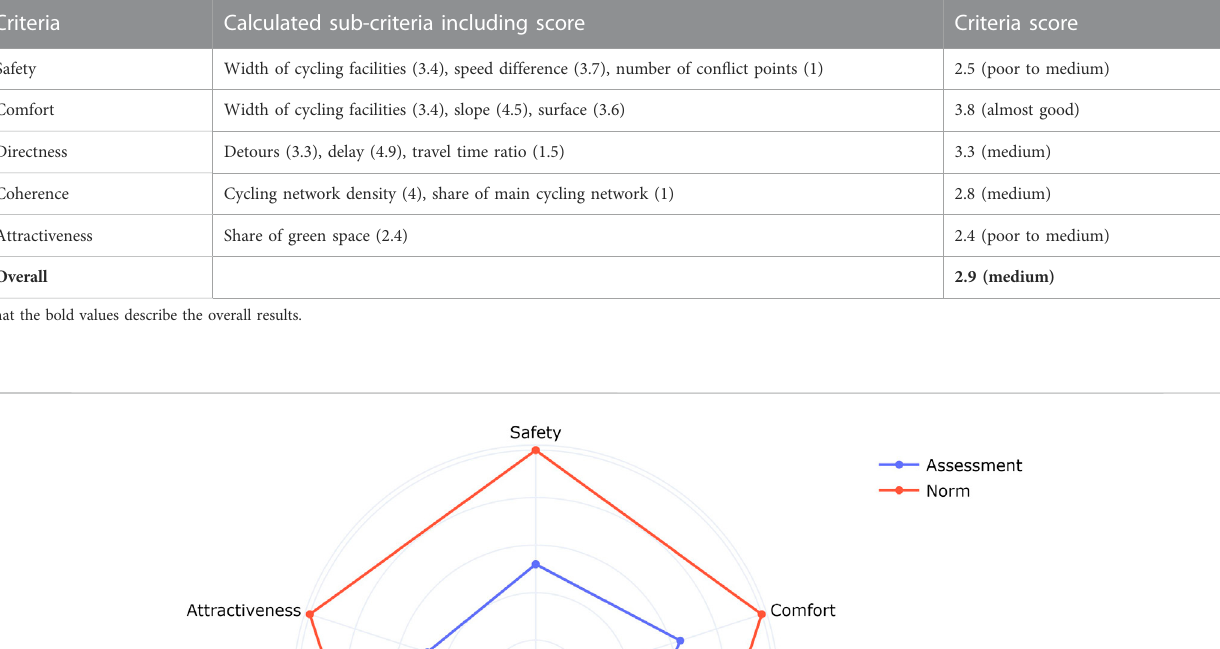
TABLE9QualityassessmentoftheMunichbicyclenetwork-calculated sub-criteriaincludingscoresandoverallscorespercriteria(1-verypoor,2-poor,3-medium, 4-good, 5-very good).